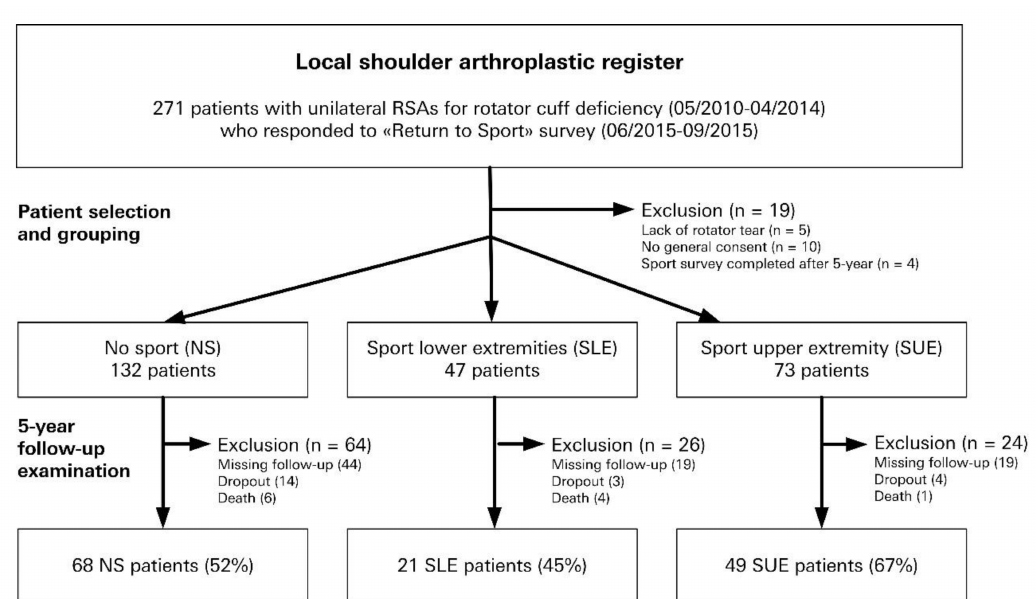
Figure 1. Flowchart visualization of the process of patient selection. RSA = reverse shoulder